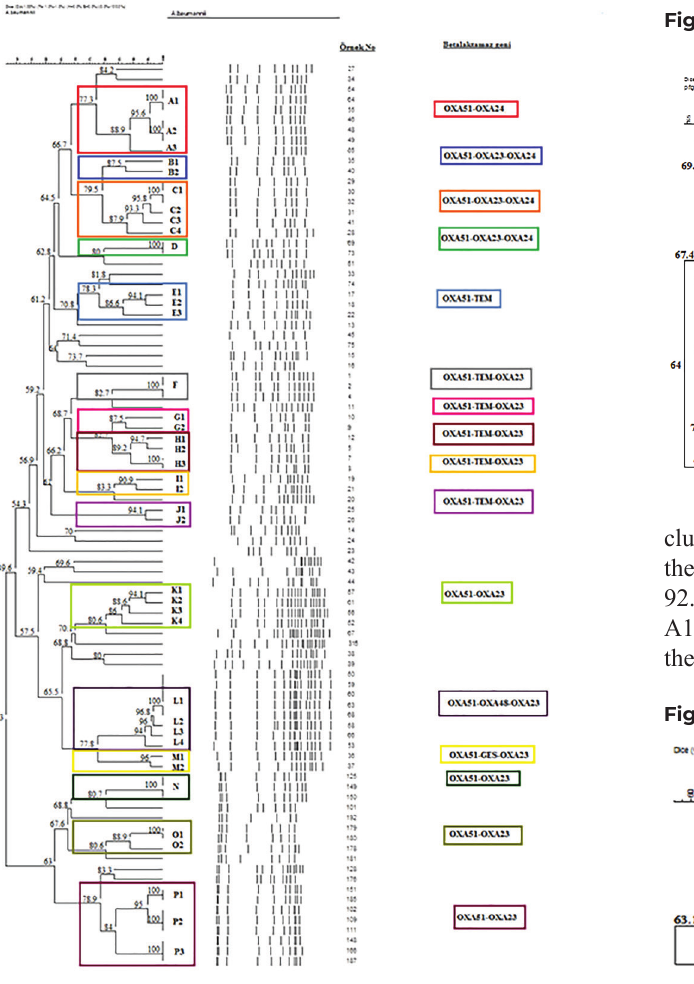
Figure 2 - Phylogenetic relationships of A. baumannii isolates.